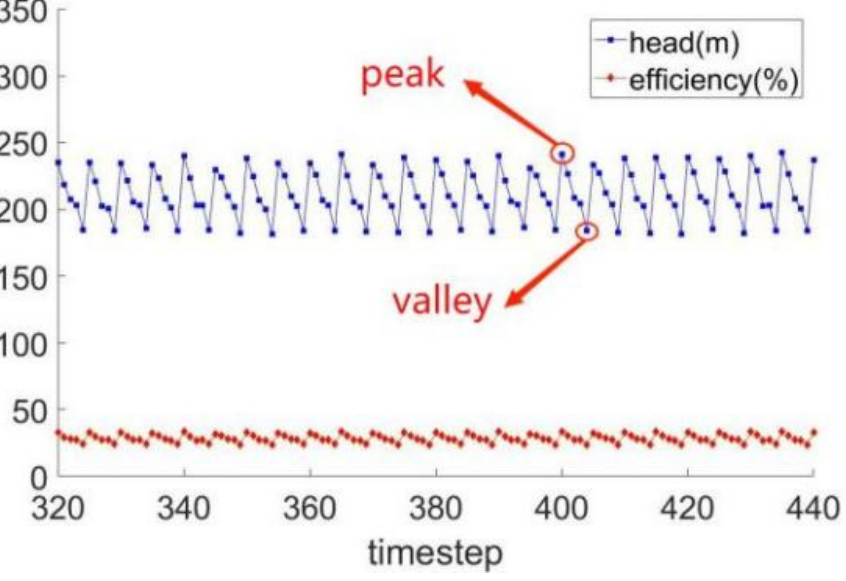
Figure 5. Schematic diagram of simulated sampling time points.